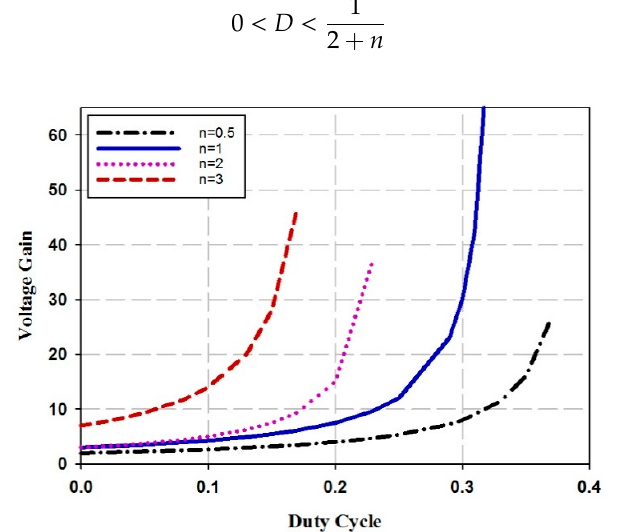
Figure 6. Voltage gain of the proposed converter for different turn ratio of coupled inductors.